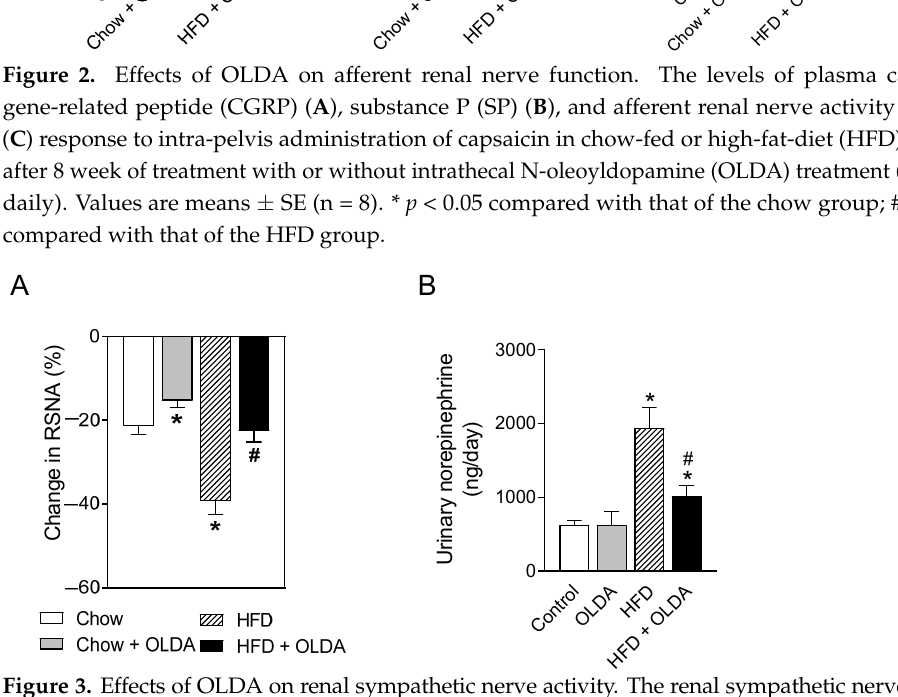
Figure 3. Effects of OLDA on renal sympathetic nerve activity. The renal sympathetic nerve activity (RSNA) response to intrathecal administration of muscimol ( A ) and the level of urinary